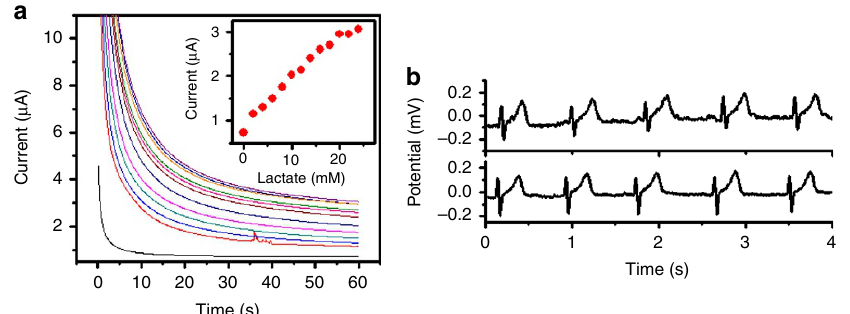
Figure 2 | In-vitro characterization of Chem–Phys hybrid patch. ( a ) Amperometric response to increasing lactate concentration from 0 to 28 with 2mM additions in phosphate buffer (pH 7.0). Applied voltage ¼ (cid:3) 0.1V versus Ag/AgCl. ( b ) Electrocardiogram signals using 3M Red Dot electrodes (top), and printed electrocardiogram sensor